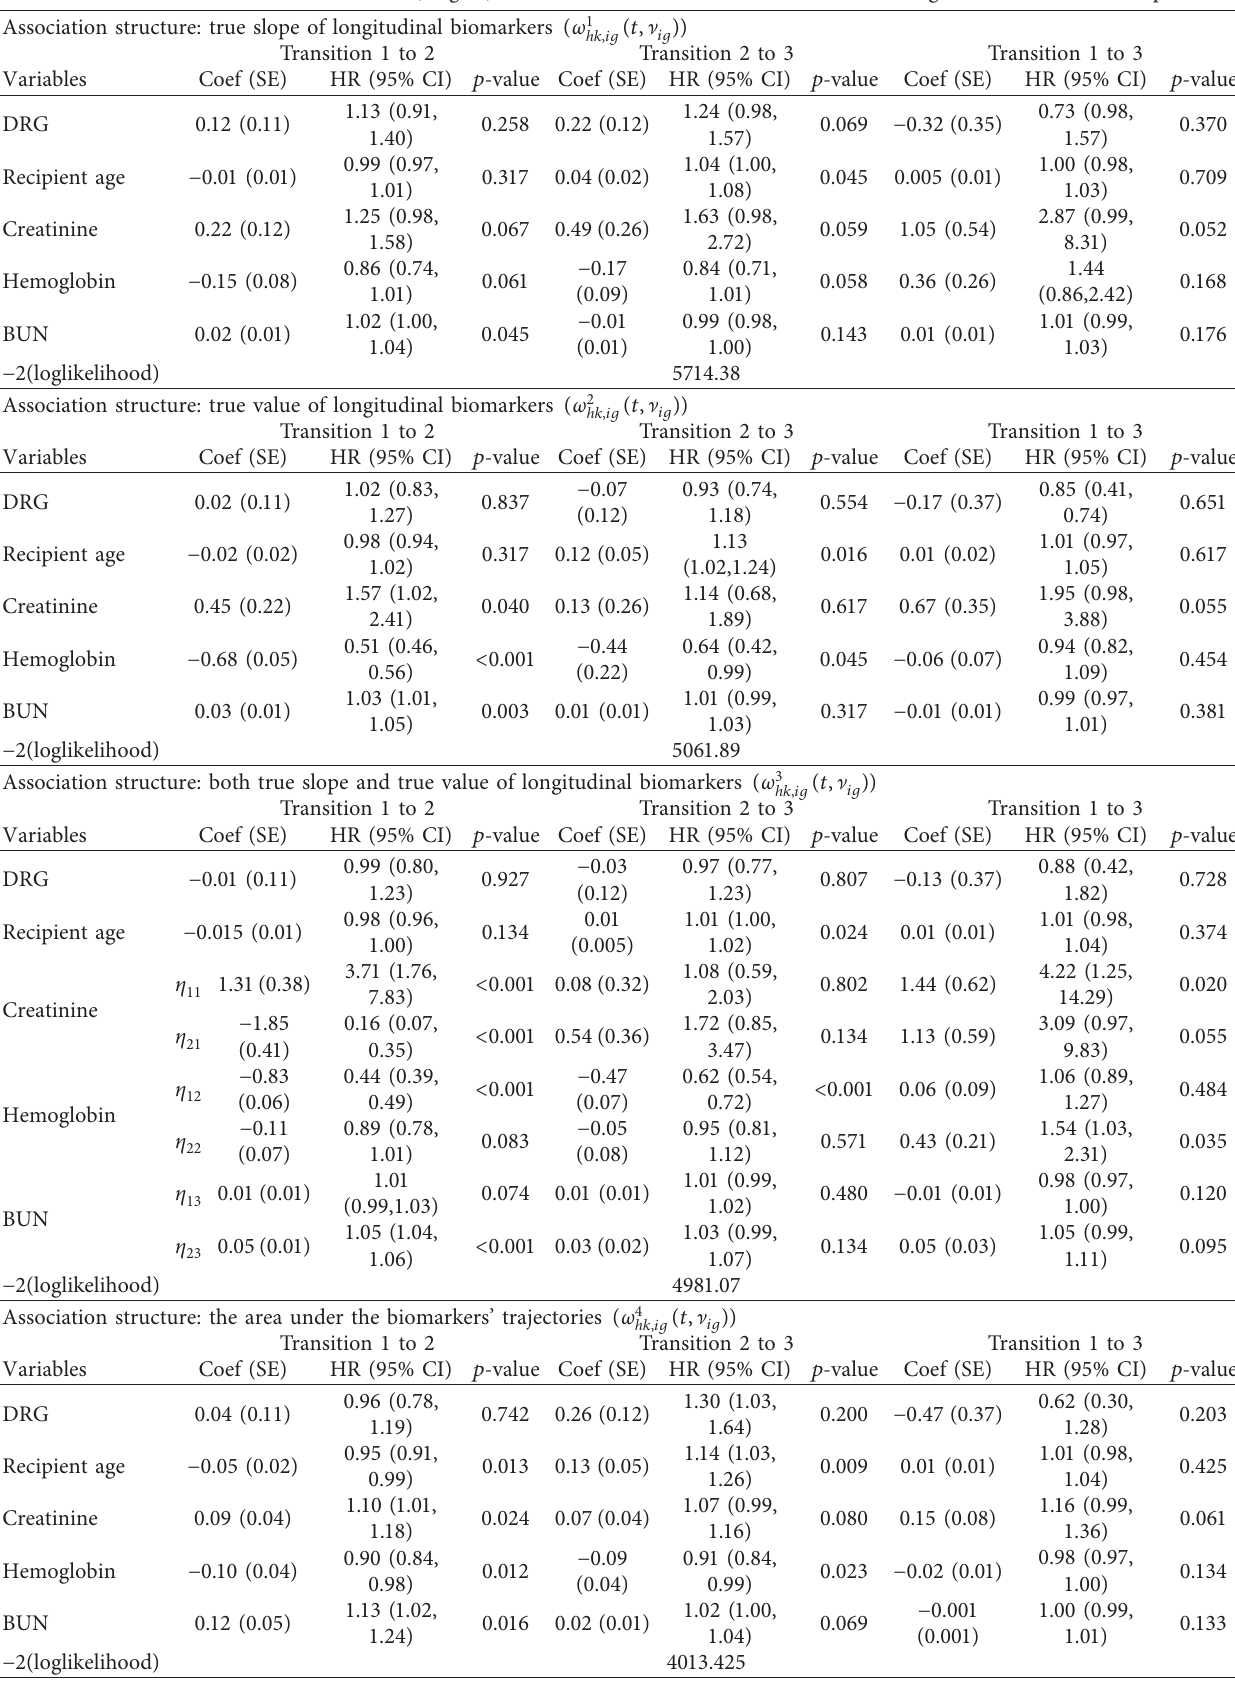
Table 3: The results of the multistate models (Stage 2) for different association structures between longitudinal and multistate